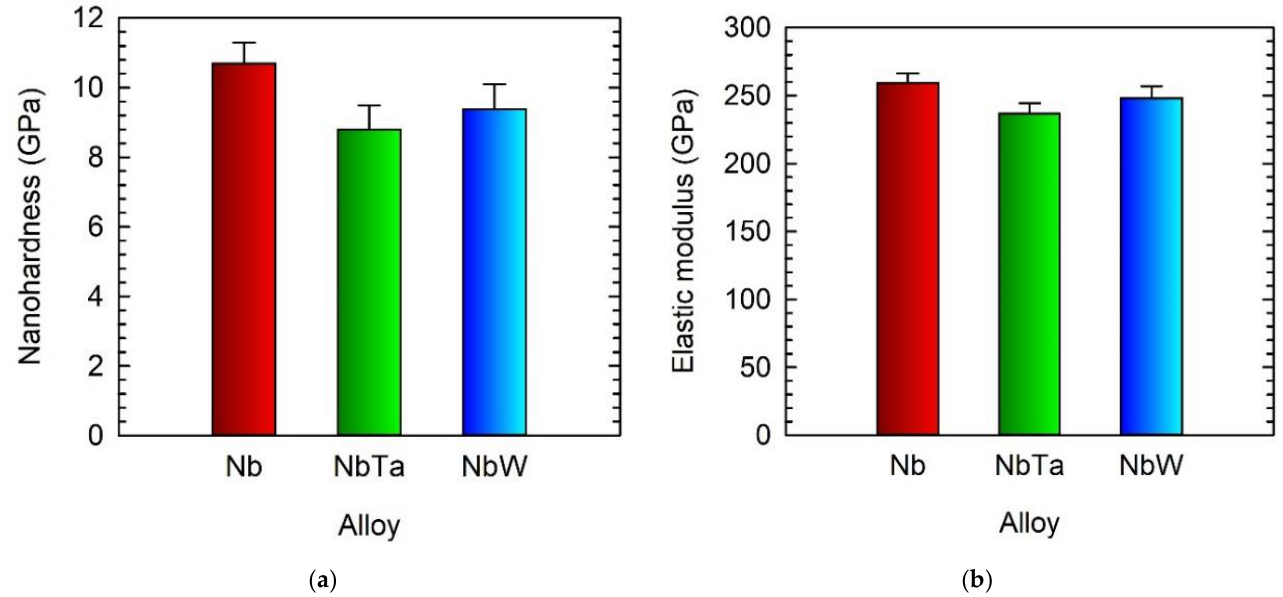
Figure 8. Nanohardness and elastic modulus of Ti 2 AlC particles in the tilt-cast Nb, NbTa, and NbW alloys: ( a ) nanohardness, ( b ) indentation elastic modulus. The studied alloys are marked in the figures.